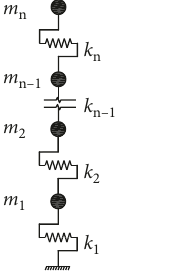
Figure 9: Structural model selected for dynamic analysis. Table 4: Comparisons of model results and test